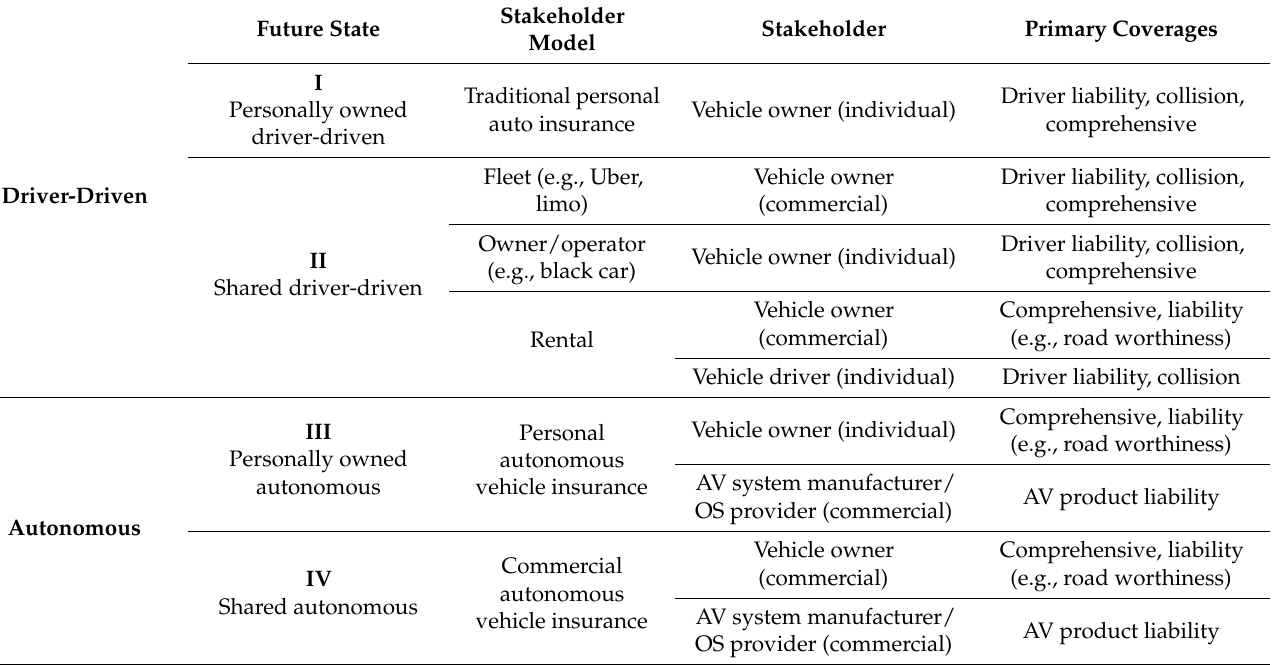
Table 4. Stakeholders and insurance products in the future of mobility adapted from